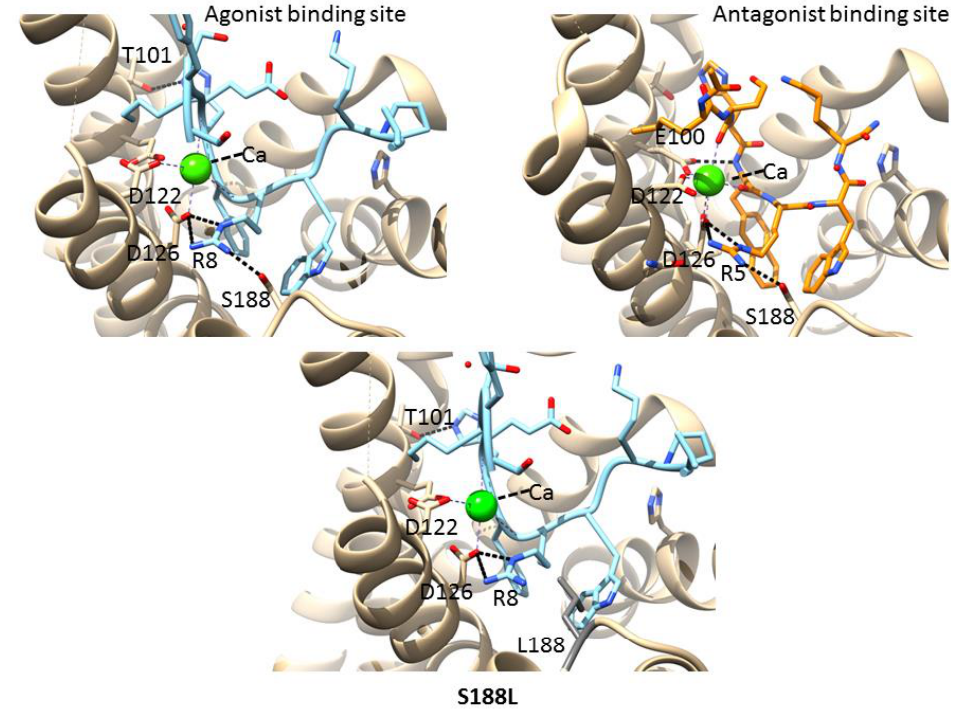
Figure 5. Mutation in the agonist/antagonist pocket. A structural view of the active site pocket (ligand as well as metal ion-binding site). Expanded view of the agonist (PDBID: 7PIV) ( left panel ) and antagonist (PDBID: 6W25) ( right panel ) binding pocket showing the interaction network among MC4R (tan), agonist/antagonist (cyan/brown), and calcium ion (green). The interactions between the metal ion, MC4R, and the agonist/antagonist are represented by the solid black lines. A mutation at position 188 from serine to leucine (S188L) would disturb the hydrogen bond network ( lower panel ). Table 1. Predicted protein stability scores of the mutants. The I-Mutant2.0 and mCSM-membrane predicted stability effects upon mutation. ΔΔG < 0 (values of energies are given in kcal/mol.) indi- cates a reduction in protein stability.